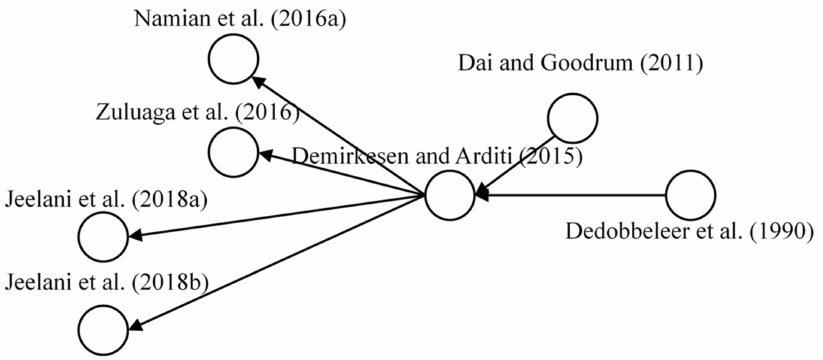
Figure 10. Main path of training of hazard perception and recognition.